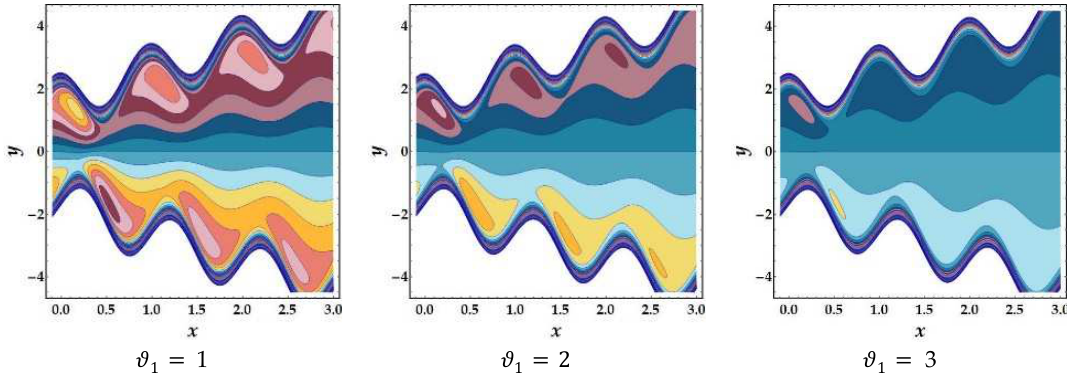
Figure 9. The behavior of Streamlines for different values of Jeffrey parameter ϑ 1 .